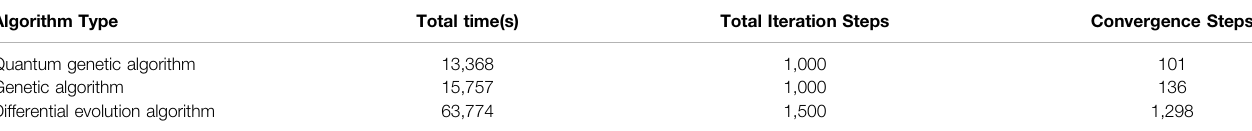
TABLE 2 | Algorithm convergence analysis results.